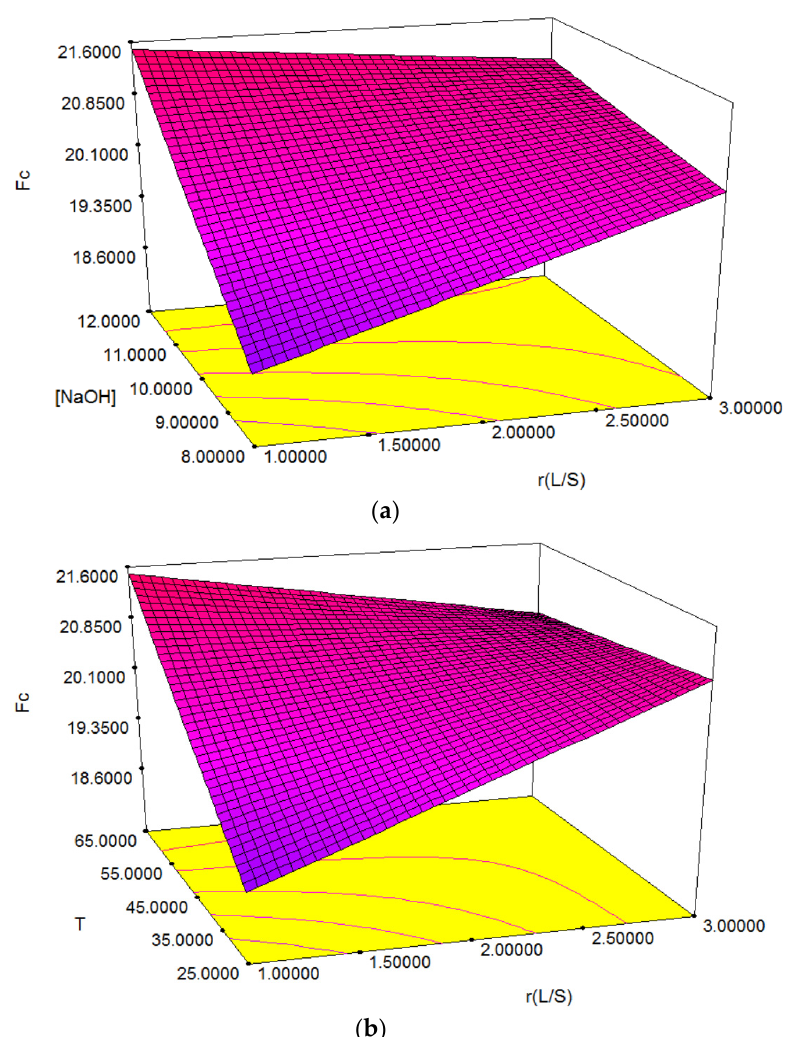
Figure 7. Response surface Fc as a function of parameters Xi and Xj (for Xk = constant): ( a ) Fc = f(X1, X2); ( b ) Fc = f(X1, X3).